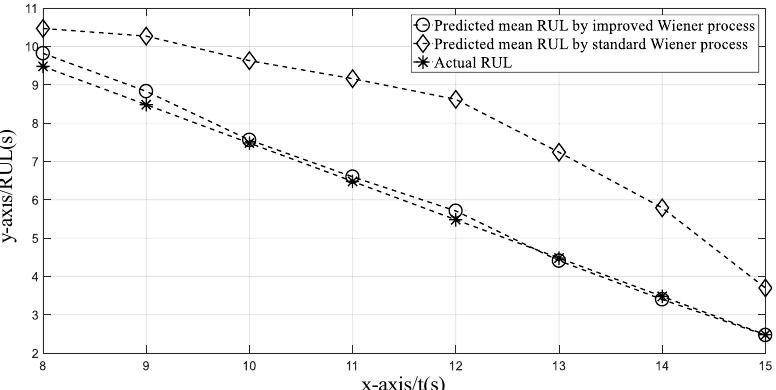
Figure 10. Mean RUL prediction